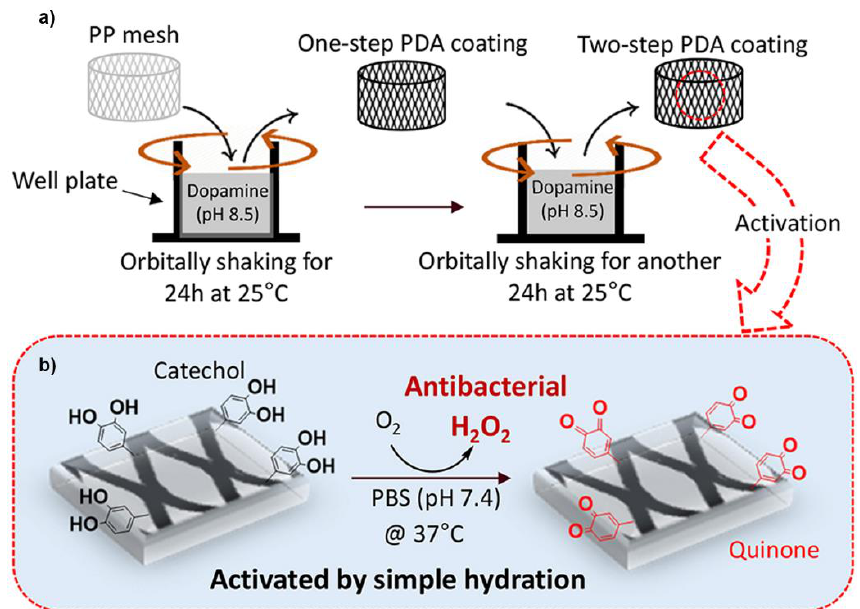
Figure 8. Schematic illustration of ( a ) catechol-based polydopamine (PDA) coating prepared by two-steps with gentle shaking and ( b ) the activation of the PDA-coated mesh to generate H 2 O 2 by simply hydrating the mesh in the PBS with at pH 7.4. Reprinted with the permission of reference [29], copyright 2019 Kord Forooshani et al.